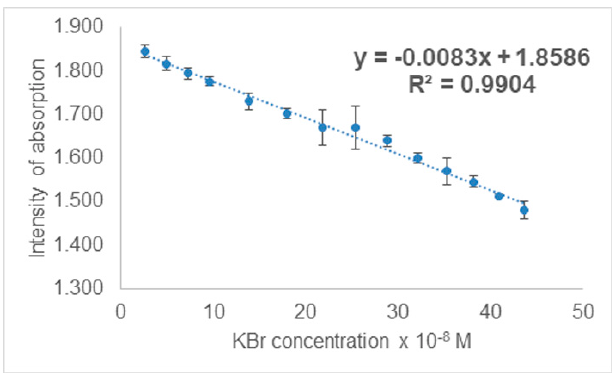
Figure 3. Linear dependence between the intensity of the absorption read at 405 nm and the Br − concentration.